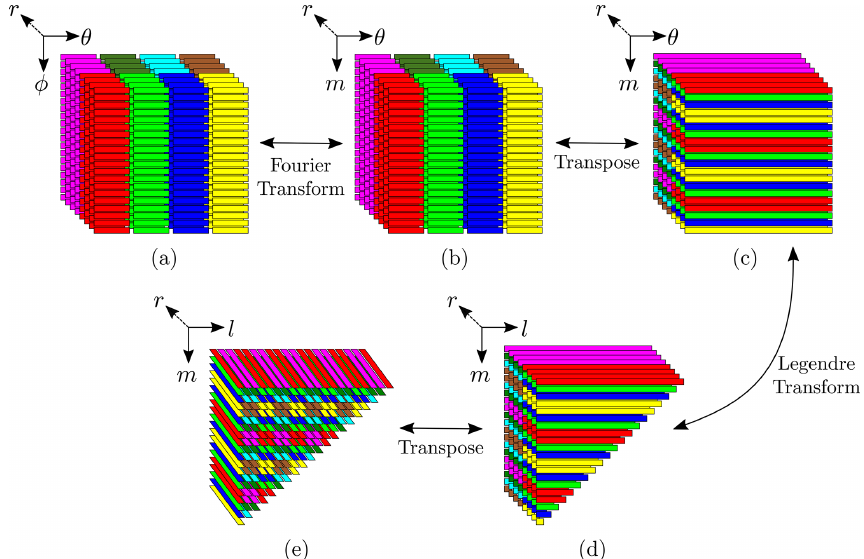
Figure 2. Illustration of the 2d-MPI distribution of the points with (cid:53) r = 2, (cid:53) θ = 4, N r = 8, and N φ = N θ = N (cid:96) = 20 (a more realistic proportion would have been N φ = 2 N θ = 3 N (cid:96) / 2). Continuous stripes represent continuous memory segments, and different colours represent distinct MPI ranks. The images show which MPI rank would store and process each data segment during (a) computation of non-linear terms, (b–d) forward SHT, and (e) the beginning of the (cid:96)